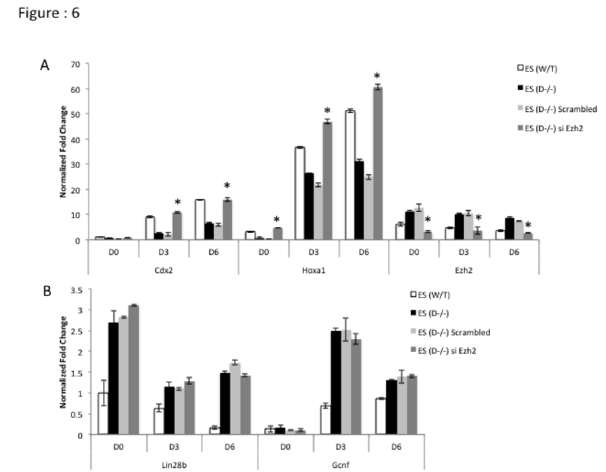
Figure 6. levels during retinoic acid induced differentiation. A) Ezh2 transcript levels reduce while Hoxa1 and Cdx2 transcript levels increase upon transfecting Dicer -/- ES cells with siRNA specific to Ezh2 . B) Lin28 b transcripts remain significantly unchanged upon transfecting Dicer -/- ES cells with siRNA specifically targeting Ezh2 . * Indicates that the differences at a given time point between Dicer -/- ES cells and Dicer -/- ES cells with si Ezh2 were significant at 0.05 confidence levels when a students t-test was